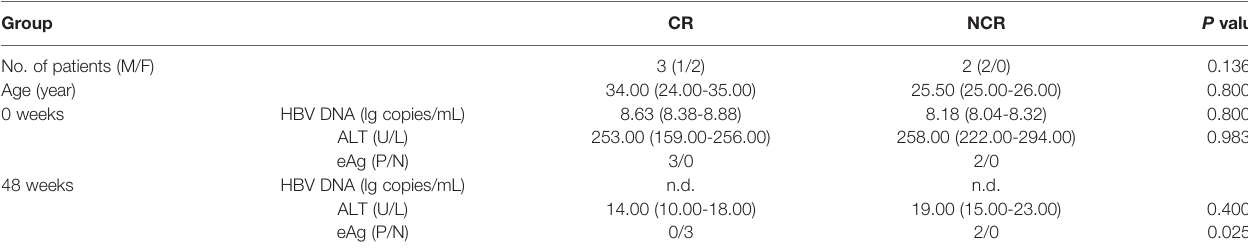
Data were shown as median (25-75% percentile). a Chi-squared